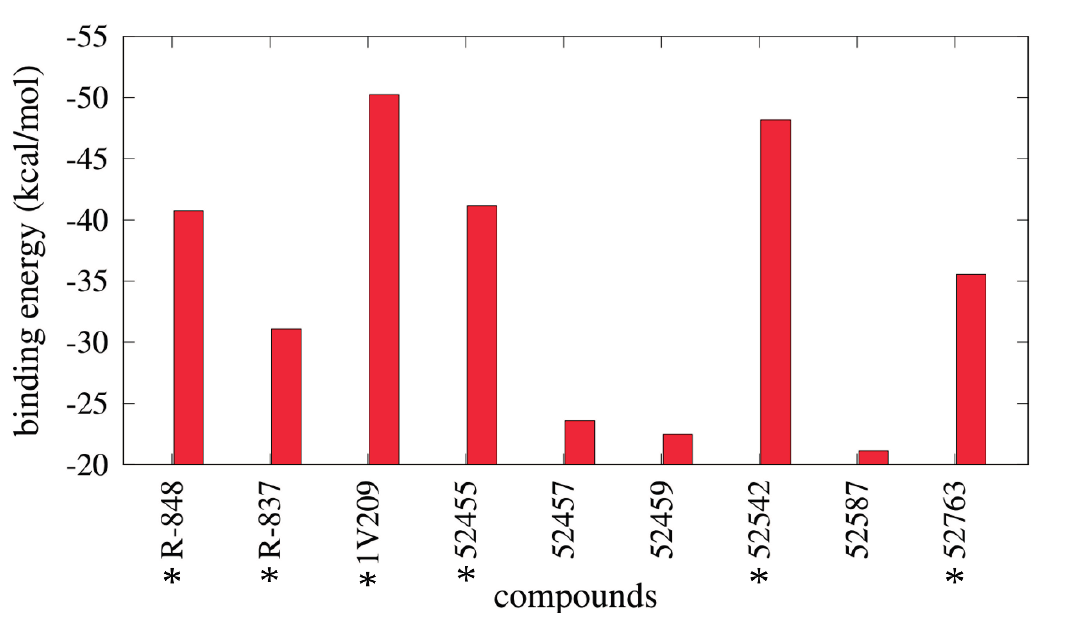
Figure 8. Binding energies derived from Molecular Mechanics Generalized Born Surface Area (MMGBSA) calculations. * indicates the TLR7 agonists.